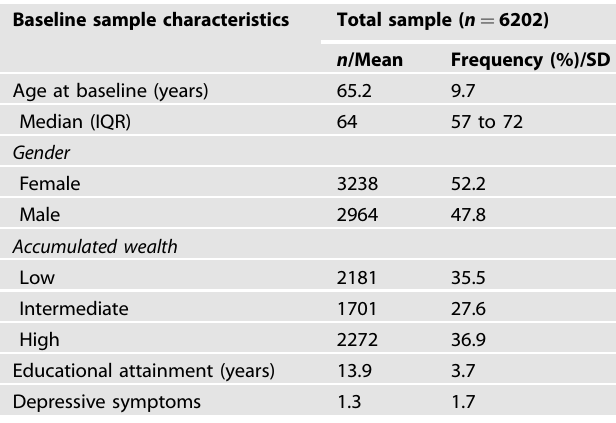
Table 1. Sample characteristics at